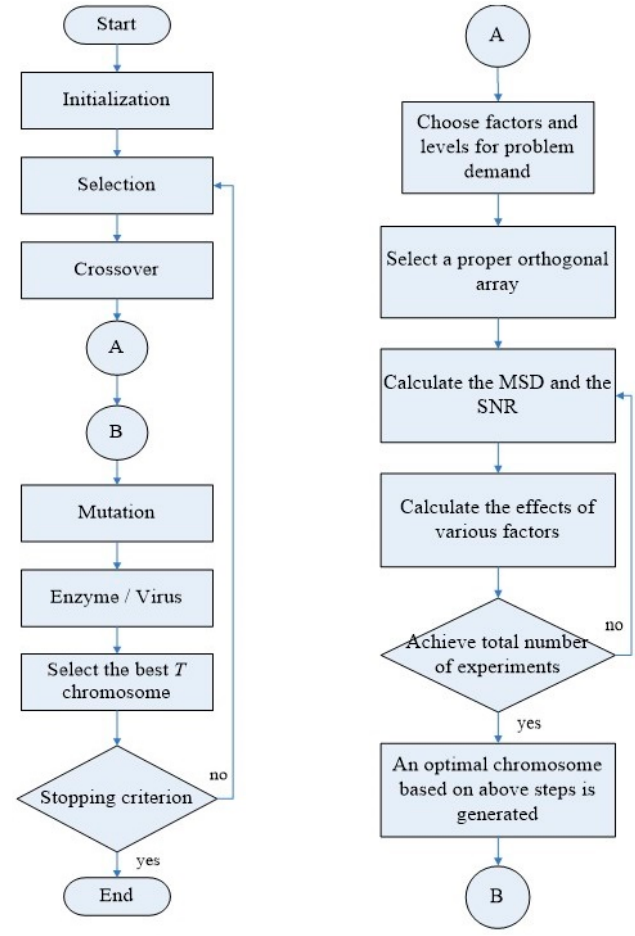
Figure 1. Flow chart for HTRDNA algorithm.